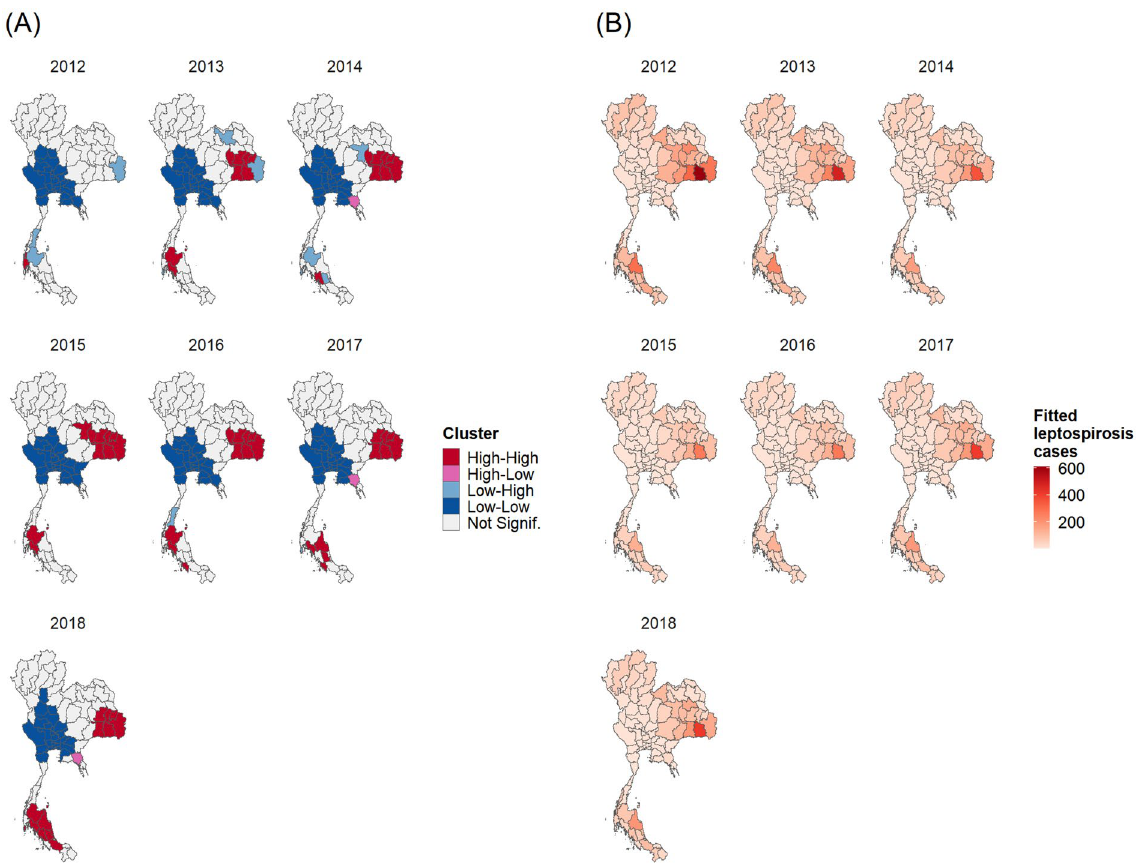
Figure 2. The plots of annual spatial clustering of incidence rate as determined by LISA ( A ) and annual leptospirosis cases estimated by the final GLMM ( B ). Maps created using R Program version 4.0.3 (https:// www.r- proje ct.